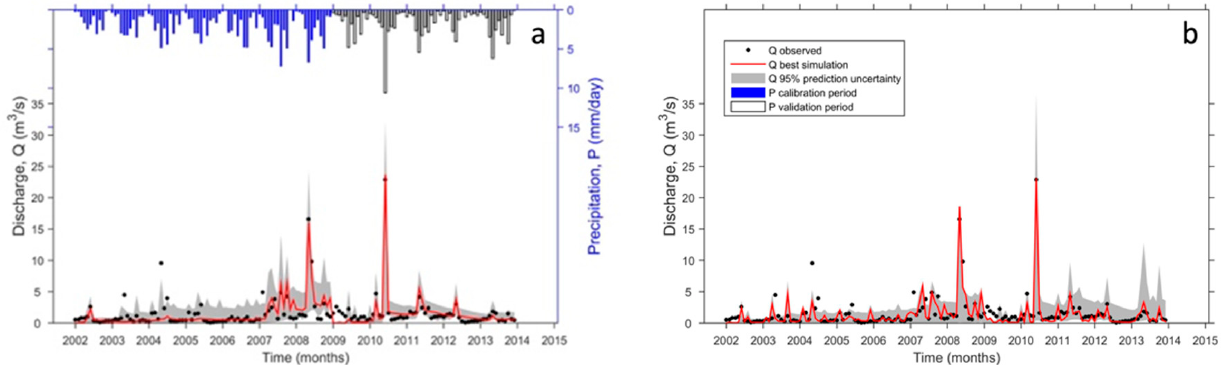
Figure 6. Streamflow simulations for the calibration and validation of the Shell Creek model using ( a ) rain gages and ( b ) radar forcings. Additionally, ( a ) inverted y-axis shows the time series of rain gage-based rainfall for the calibration and validation periods. The legend box applies to both, ( a , b ).